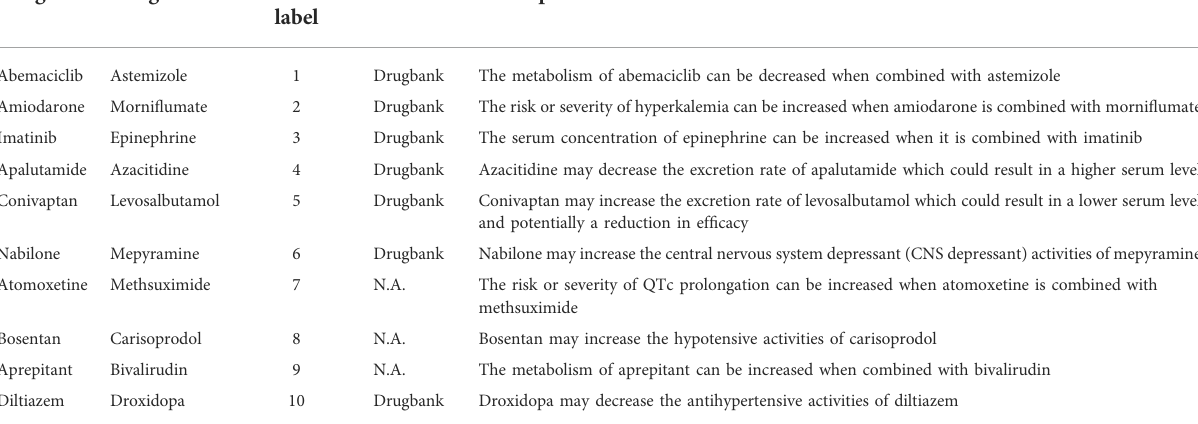
TABLE 7 Predicted results for the top 10 types of reaction events.